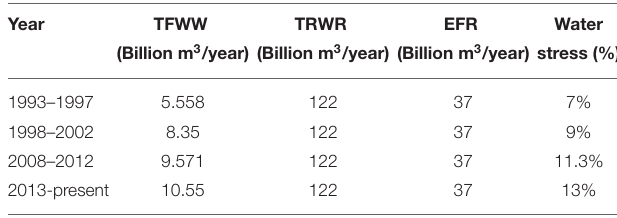
TABLE 5 | Total renewable freshwater resources (TRWR) and total freshwater withdrawn (TFWW) of Ethiopia and its implication for water